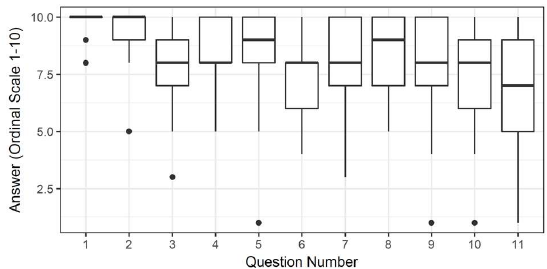
Figure 10. Answers to questions with ordinal-scale answers (10 - high/good and 0 - low/bad) – question number as in Table 3. Boxes represent median and 25th and 75th percentile